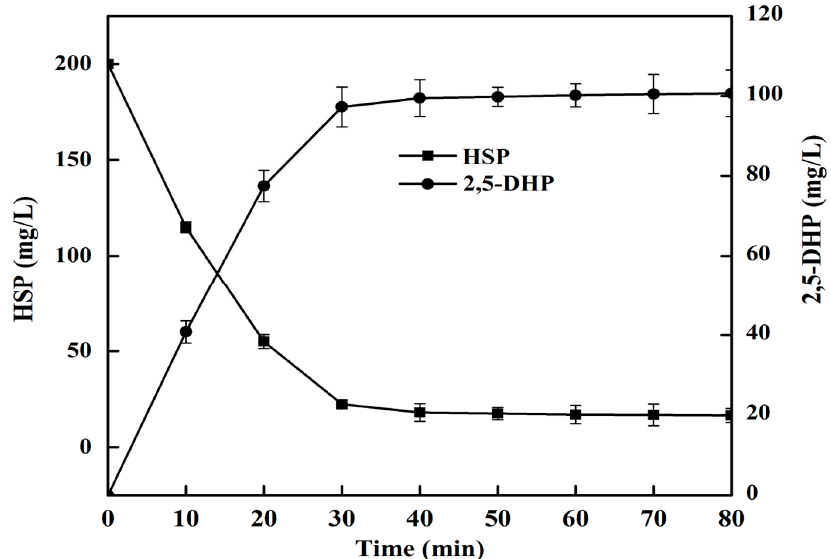
Figure 7. Time course of 2,5-DHP ( circles ) production from HSP ( boxes ) for ImmHSPH ZZ under the optimum condition.